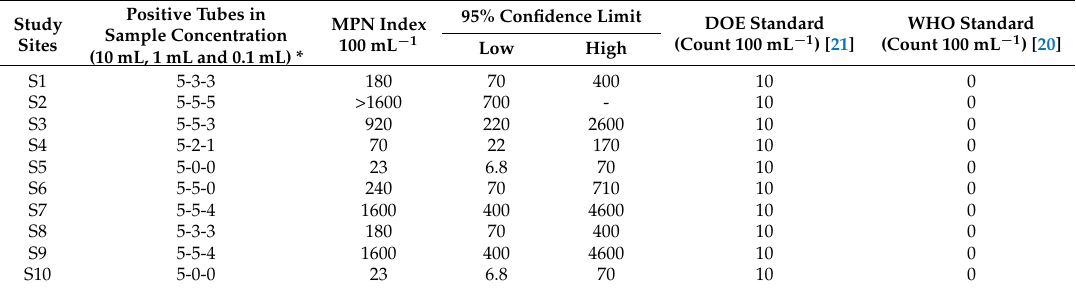
Table 3. The most probable number (MPN 100 mL − 1 ) table for (five-tubes methods) confirmed the test analysis of the faecal coliform bacteria in ten rivers in Bintulu, Sarawak, Borneo. Study Sites